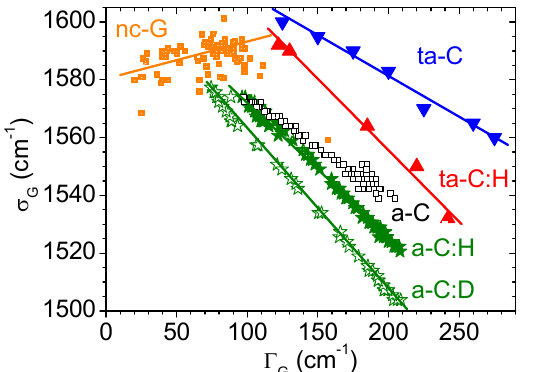
Figure 23. Temperature evolution of σ G for a DLCH sample (H/H + C = 29%). In situ measurement is done in an environmental cell, under argon atmosphere to avoid oxidation.